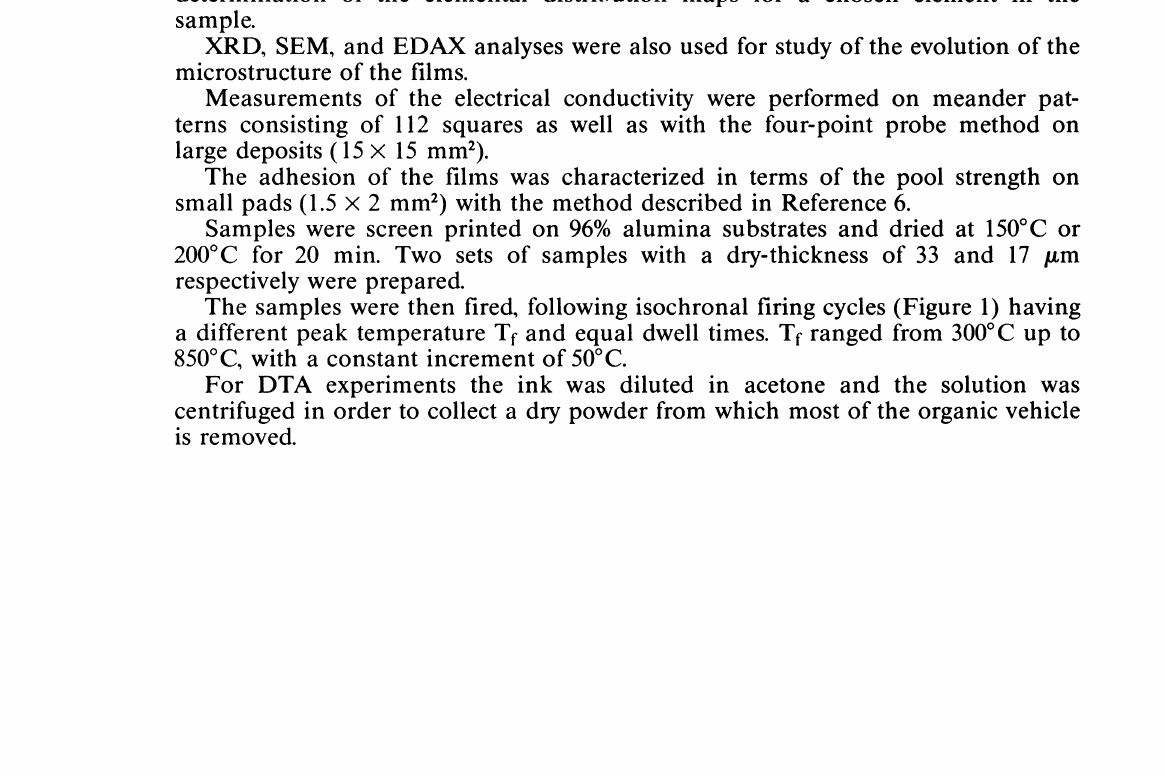
Some isochronal firing cycles for the preparation of samples of the present FIGURE